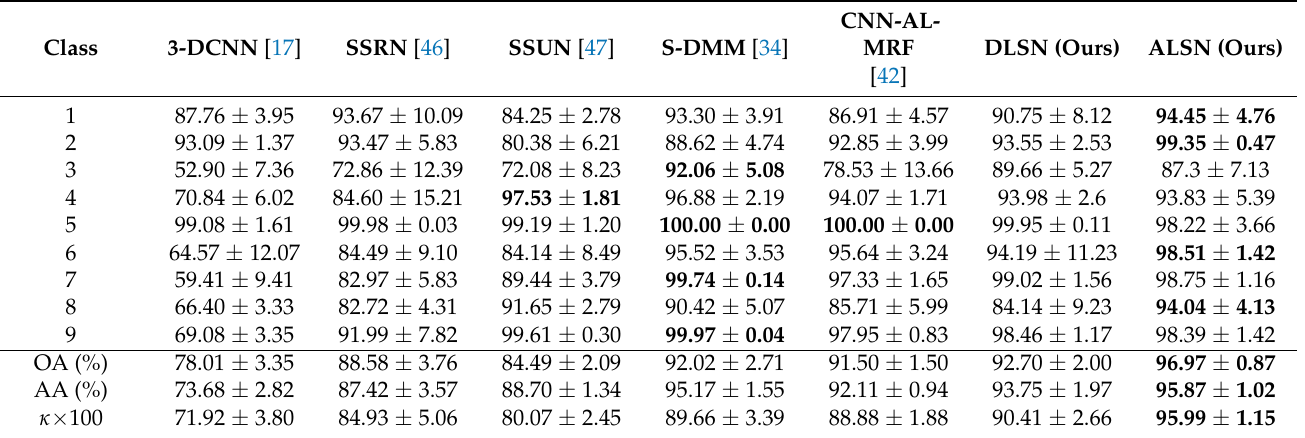
Table 5. Classification accuracy (%) for PaviaU dataset (9 iterations for AL methods and 19 labeled samples per class for other methods).